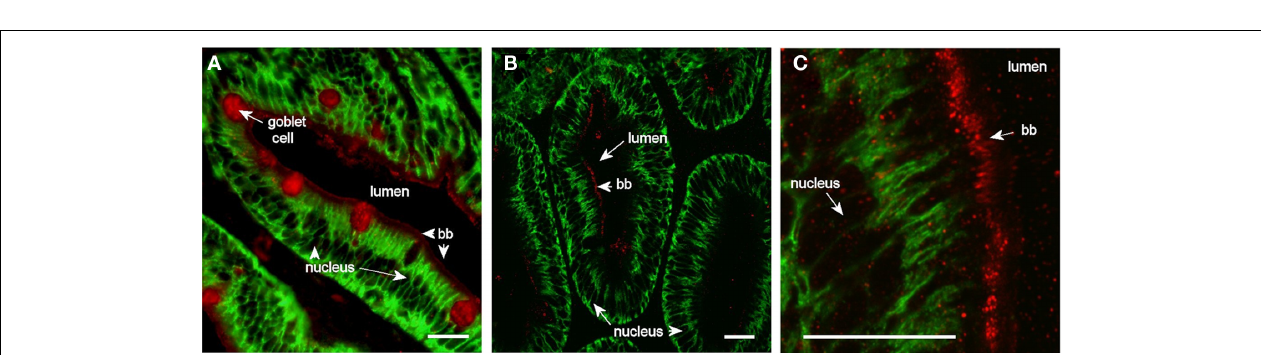
FIGURE 6 | Fluorescent microscope images (40 × objective) showing localization ofAqp1aa (A),Aqp1ab (B), andAqp8ab (C) in pyloric caeca from SW-acclimatedAtlantic salmon. Sections were incubated with antibodies against the aquaporin (red), Na + , K + -ATPase (green), and nuclei